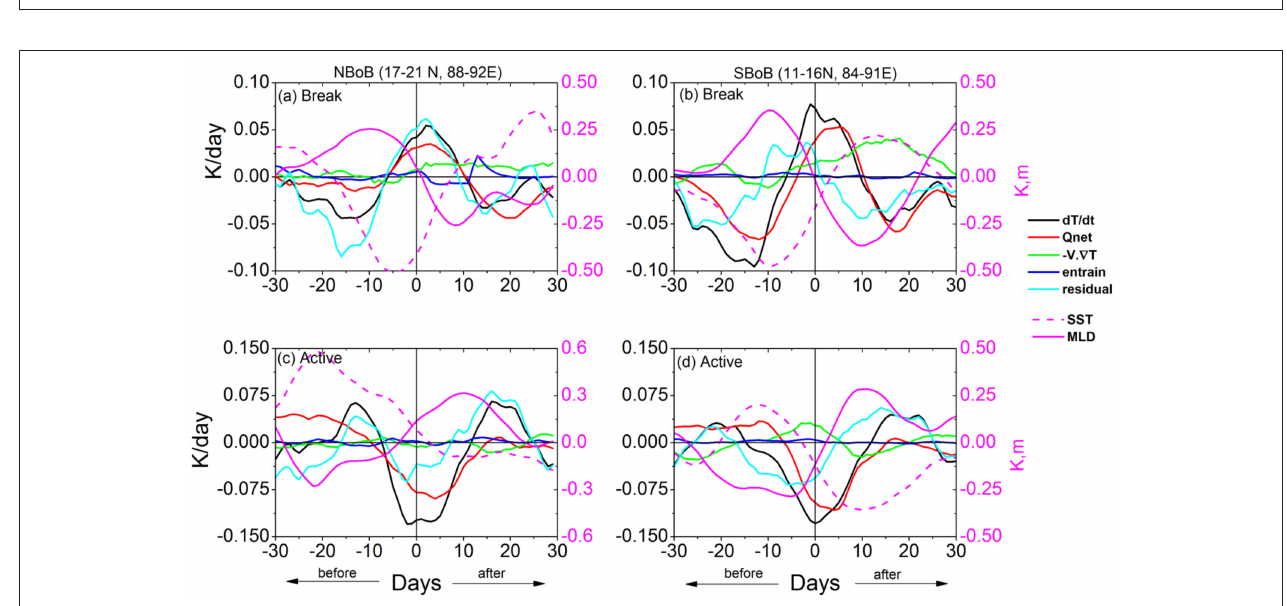
FIGURE 10 | Same as Figure 8 , but for ML budget from CFSR